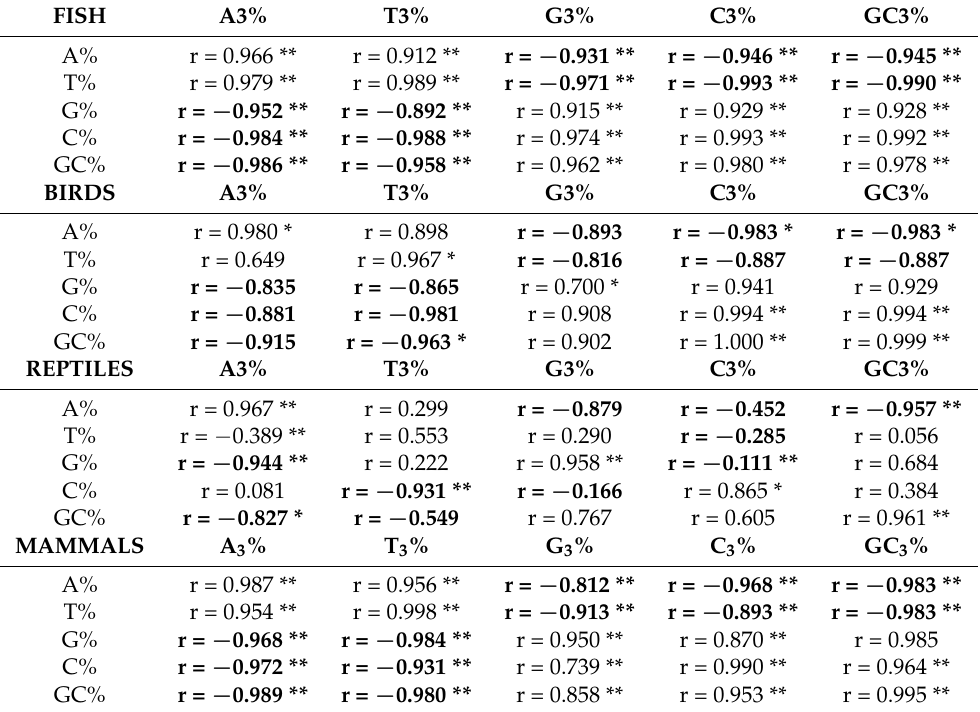
Table 2. Correlation analysis between overall nucleotide and the corresponding nucleotide at the third codon